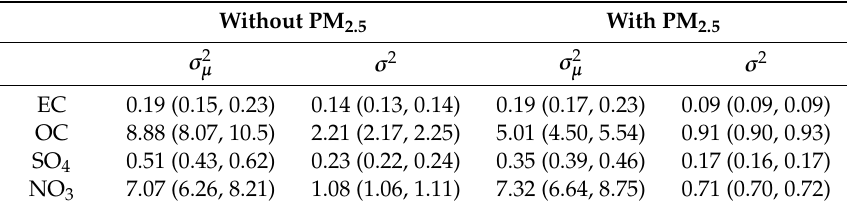
Table 2. Posterior mean and 95% posterior interval of BART variance parameters from models with and without PM 2.5 as a predictor. Parameter σ 2 µ describes the variability in terminal nodes across trees and σ 2 describes the residual variability not explained by the ensemble trees. Without PM